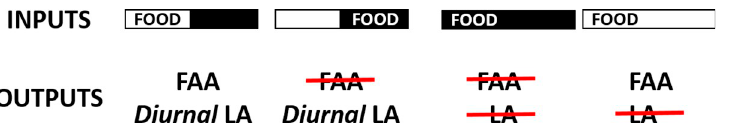
Fig 9. Summary outline from behavior experiments of the inputs regulation (scheduled feeding and light) of the outputs (Locomotor activity (LA) and FAA) in turbot juveniles under laboratory conditions. The rectangle represents the light phase (white) and the dark phase (black) within a period of